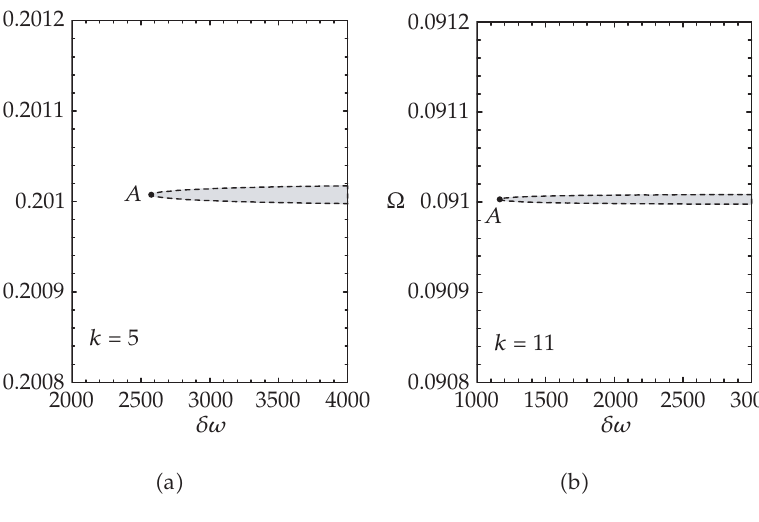
Figure 7.2 . The same as in Figures 7.1a and 7.1b but for L = 1000. The error was calculated using ( 5.8 )